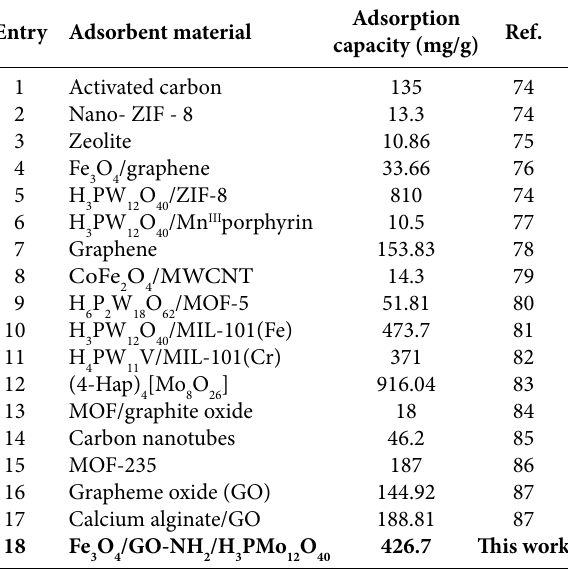
Table 1 . Comparison of the adsorption capacities of MB onto some typical adsorbents. Entry Adsorbent